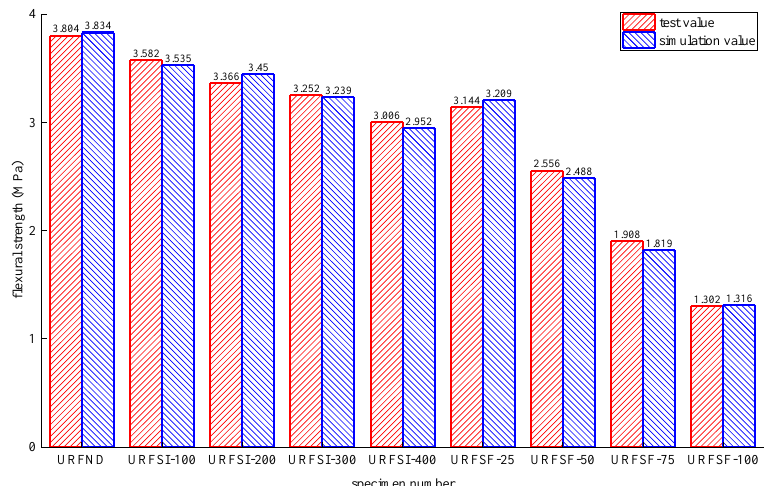
Figure 40. Test values and simulated values of flexural strength of unreinforced concrete flexural specimen.